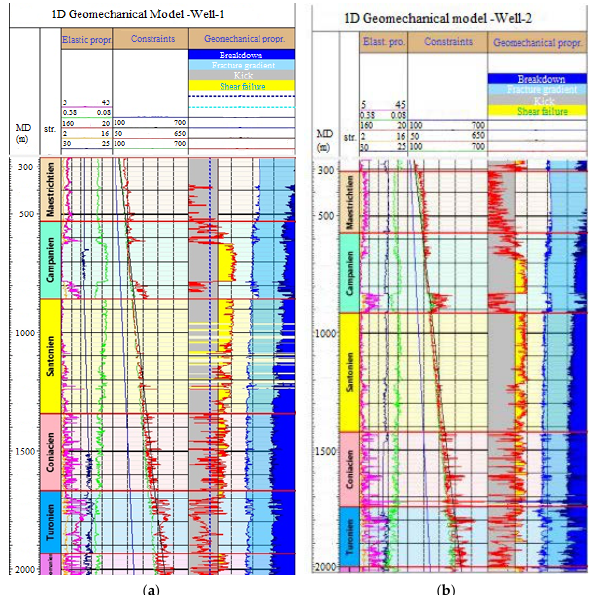
Figure 3. One-dimensional (1D) geomechanical model and mud density analysis for: ( a ) well 1, ( b ) well 2. The description of the curves from left to right is as follows: track 1—MD: measured depth (m), track 2—stratigraphy: limits of the geological formations, track 3—Young’s static modulus (GPa) curve in violet; Poisson ratio curve in light green; UCS (MPa) curve in red; TSTR (MPa) curve in yellow; and friction angle (Deg) curve in dark blue, track 4—interstitial pressure (Psi) curve in dark blue; vertical stress (Psi) curve in black; horizontal constraints (Smax in red, Smin in light green, Psi), track 5—the windows of wellbore stability, including interstitial pressure in grey, shear failure of the wellbore in yellow, fracture gradient in light blue and breakdown in dark blue [23].